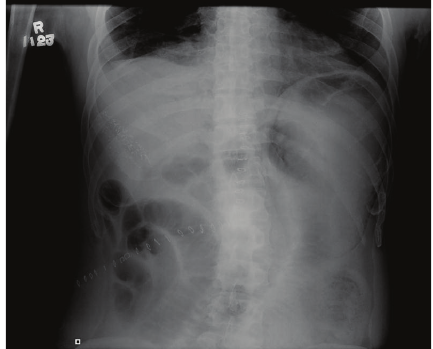
Figure 2: Abdominal radiograph on postoperative day 4: lucency in the stomach and small bowel